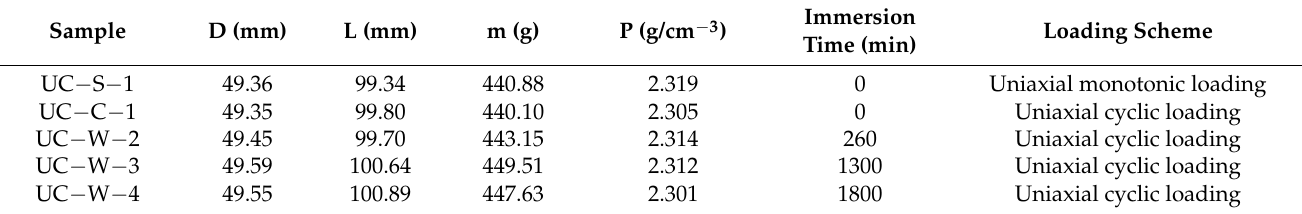
Table 1. Physical parameters of tested sandstone specimens and loading scheme in this study. D and L represent diameter and length, respectively; m is rock mass and ρ is